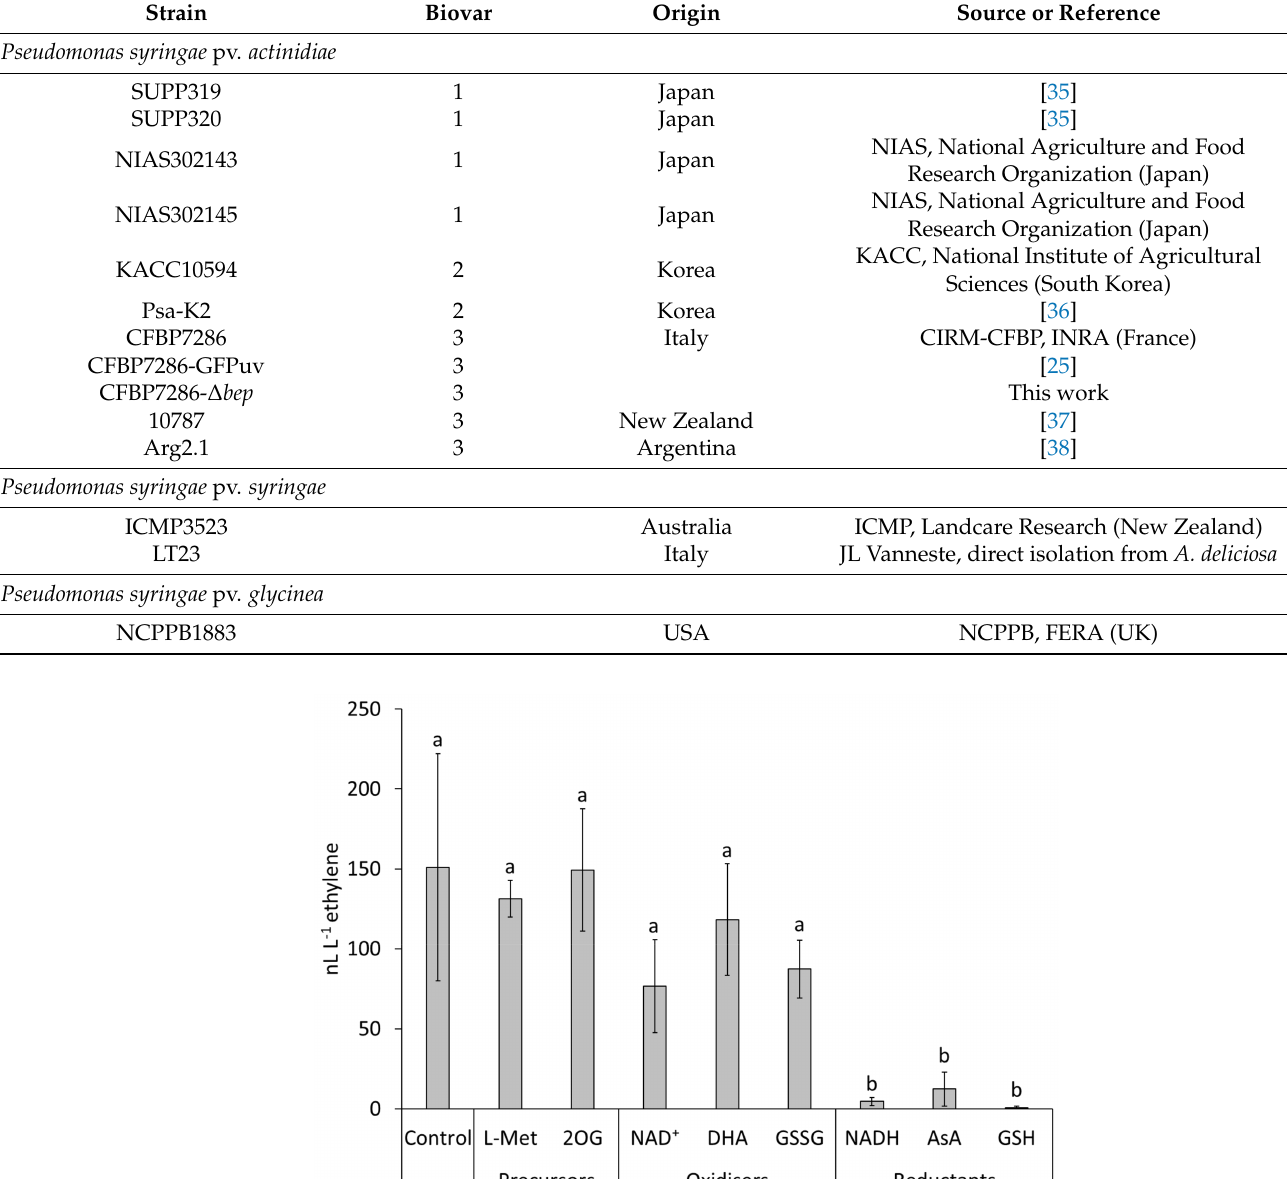
Table 1. List of the Pseudomonas syringae pathovars and strains used in this work.